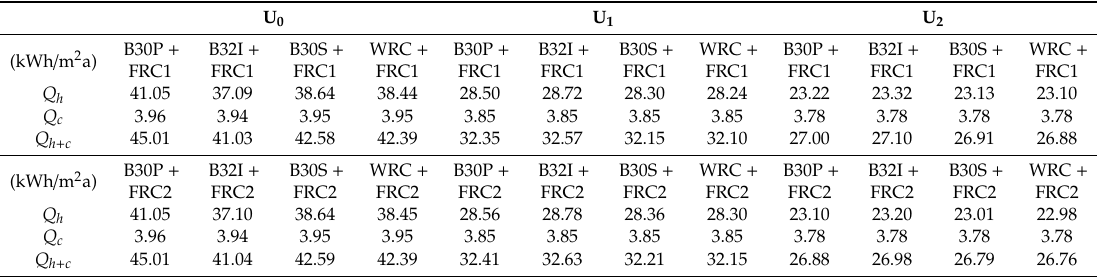
Table 3. Result of energy balance for defined